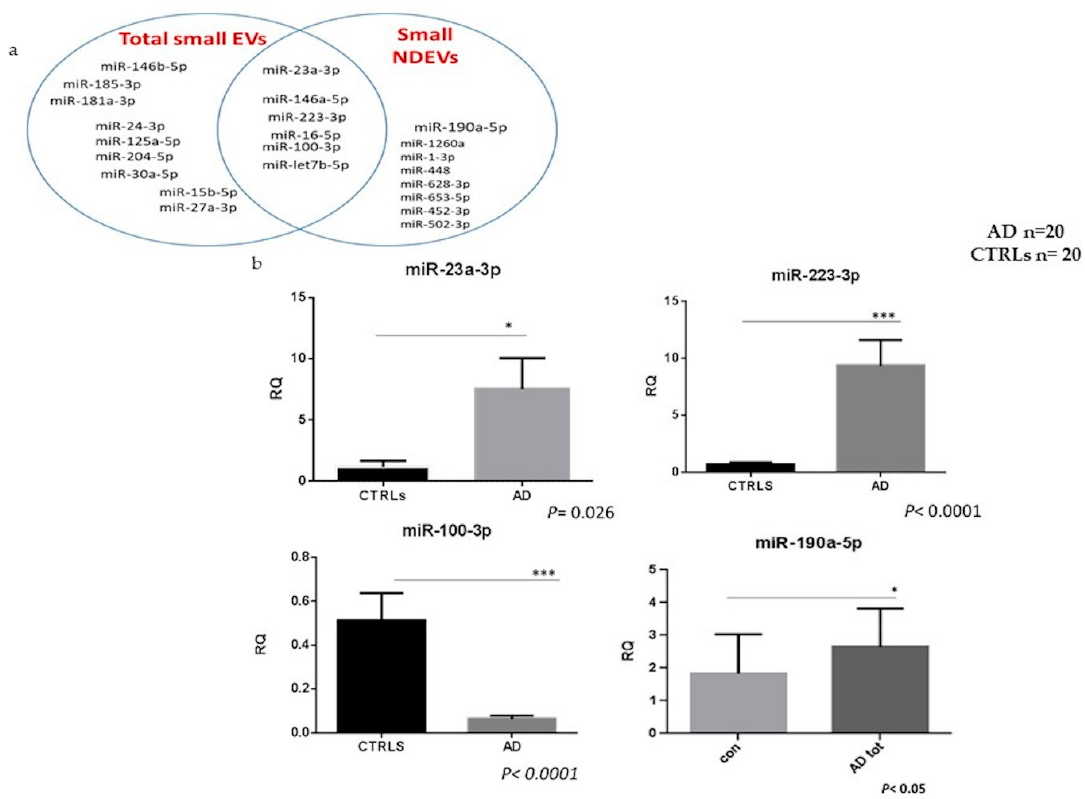
Figure 4. ( a ) Hierarchical clustering of samples based on microRNA (miRNA) profiles observed in total plasma EVs from AD patients and CTRLs. The most variant (according to coefficient of variation) miRNAs detected in NDEVs were used for clustering analysis (Pearson correlation, average linkage). Rows are centered and unit variance scaling is applied to normalized expression values. Color indicates relative up- (red) or downregulation for each miRNA (row). ( b ) Principle component analysis based on the most variant miRNAs in NDEVs.